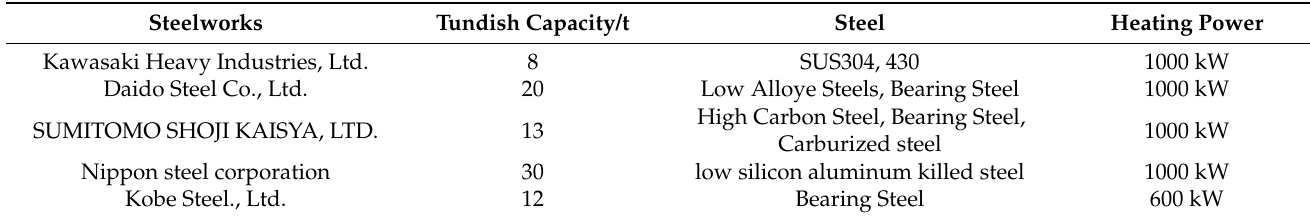
Table 2. The application case of channel-type IHT technology